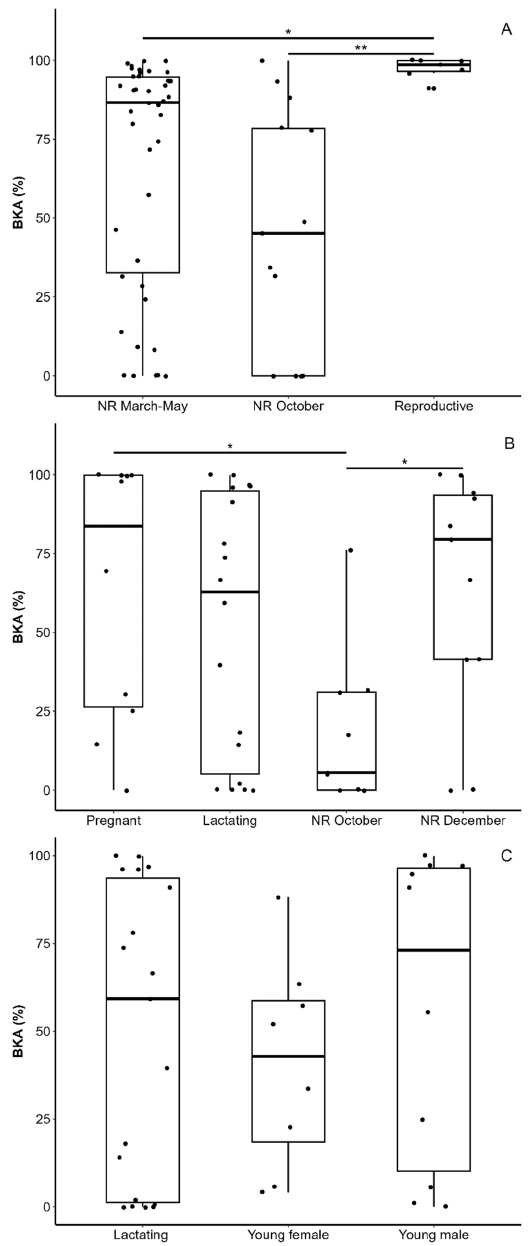
Figure 4. Bacteria-killing ability (BKA) in plasma of lesser long-nosed bats ( Leptonycteris yerbabuenae ) for ( A ) non-reproductive (NR) adult males in March 2019 and 2020 and May 2019 (inguinal or scrotal testicles and no dorsal patches), in October 2019 (scrotal testicles and no dorsal patches), and reproductive males in December 2019 (males with scrotal testicles and a fresh dorsal patches) captured in west-central Mexico; for ( B ) pregnant and lactating females captured in northern Mexico in May and July–August 2019 and adult females with no external signs of pregnancy or lactation (ANR) captured in west-central Mexico in October and December 2019; and for ( C ) lactating females and young males and females captured in northern Mexico in July–August 2019. Values are medians (squares), interquartile ranges (boxes), and 5–95% percentiles (whiskers). Significant differences in pairwise comparisons are shown ( p ≤ 0.05 *, p ≤ 0.01 **) based on a generalized linear model with a zero-inflated beta